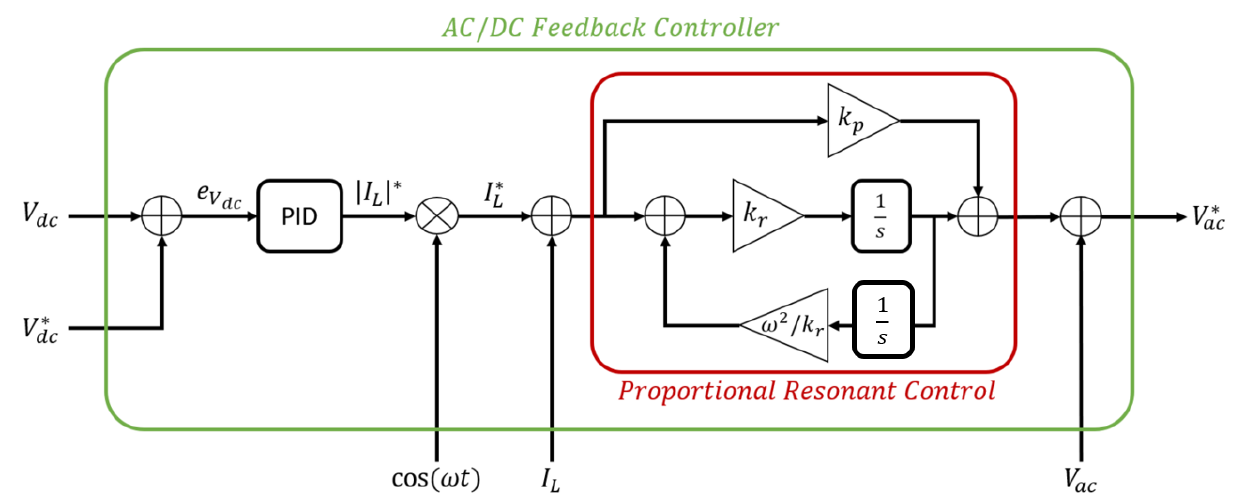
Figure 6. Block diagram representation of the current/voltage feedback